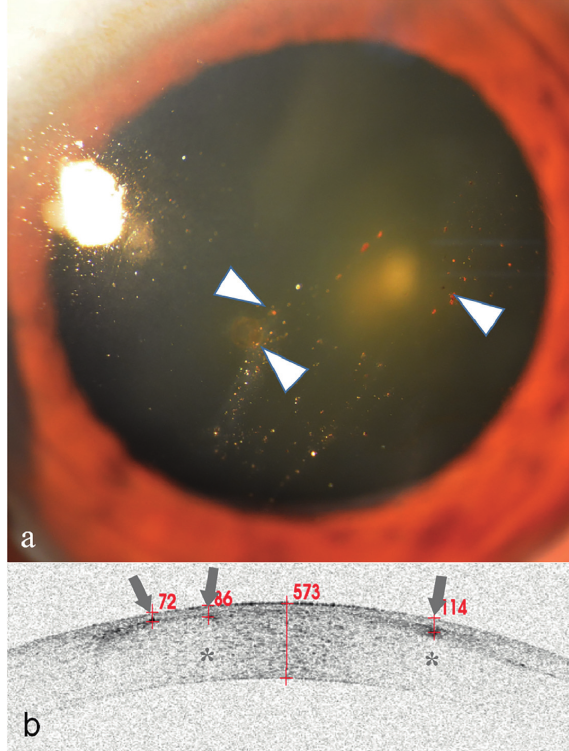
Figure 2: Anterior segment and AS-OCT image for Case 2. (a) Anterior segment photograph showing multiple small granular corneal lesions in the shallow cornea (arrowheads). (b) AS-OCTshowed that there were three high signals with blurred boundary (arrows). Two of the signals had a central zone shadowing effect (stars). They were directly located and were 72, 86, and 114 μ m beneath the corneal